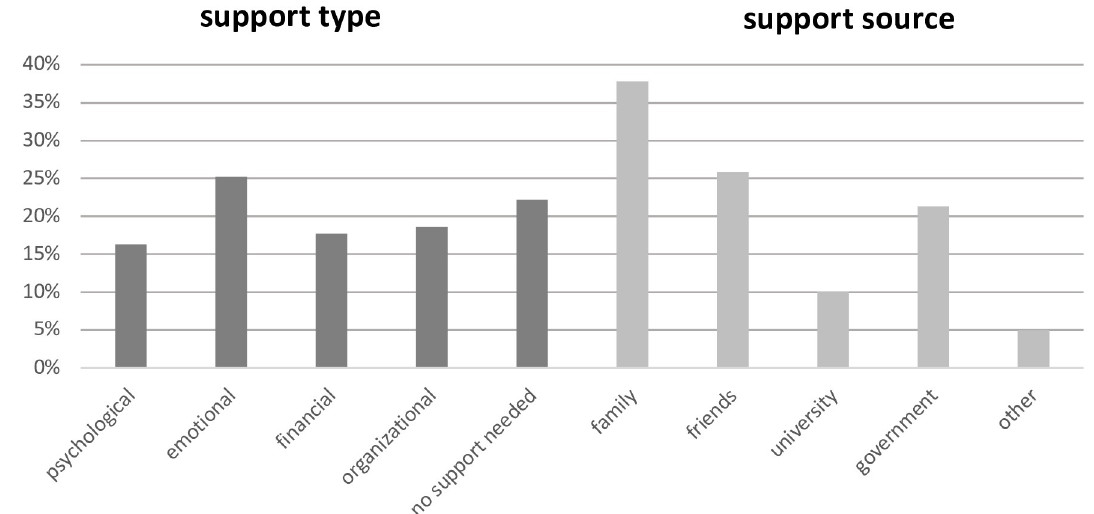
Fig 1. Support expected during the pandemic: Type and